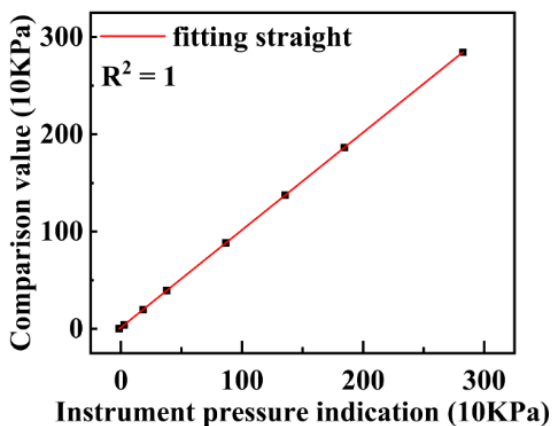
Figure 6. Results of the pressure sensor calibration experiment.